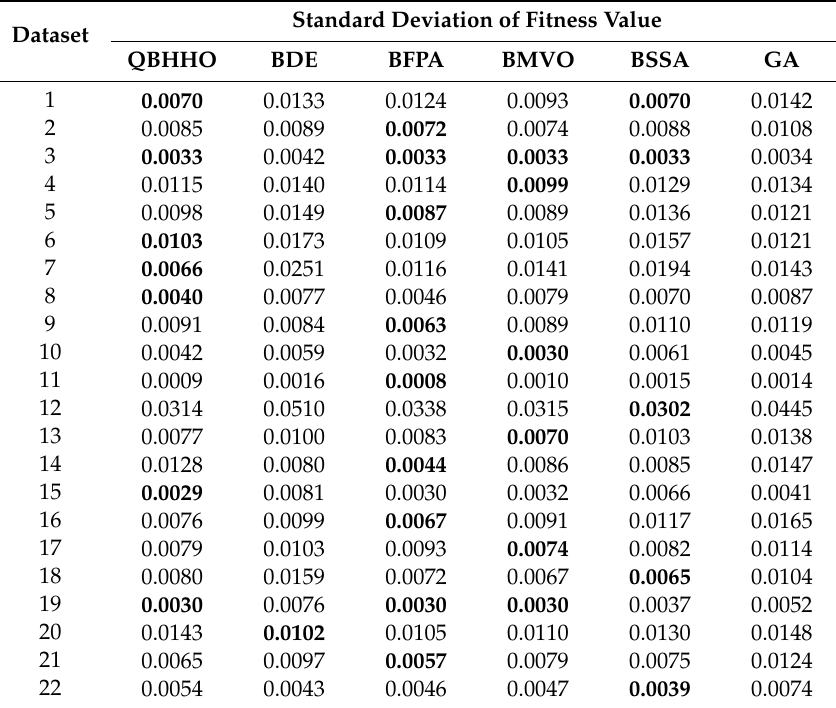
Table 12. Experimental result of the STD of six di ff erent